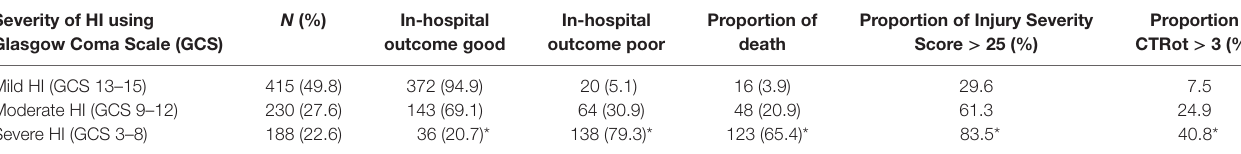
Table 5 | Road-traffic injury-related head injury (HI) from Nigeria: in-hospital outcome and determinants. severity of hi using N (%) glasgow coma scale (gcs)